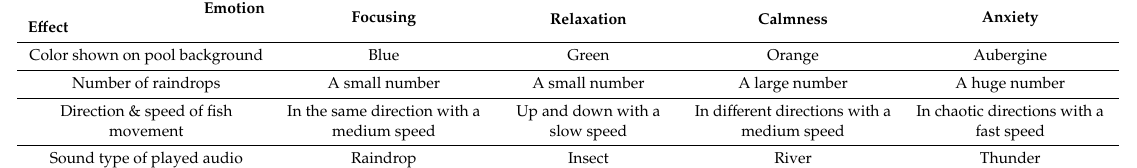
Table 3. List of the animation scenarios played on the panel of the interaction pool. Emotion Focusing Relaxation Calmness Anxiety E ff ect Color shown on pool background Blue Green Orange Aubergine Number of raindrops A small number A small number A large number A huge number Direction & speed of fish In the same direction with a Up and down with a In di ff erent directions with a In chaotic directions with a movement medium speed slow speed medium speed fast speed Sound type of played audio Raindrop Insect River